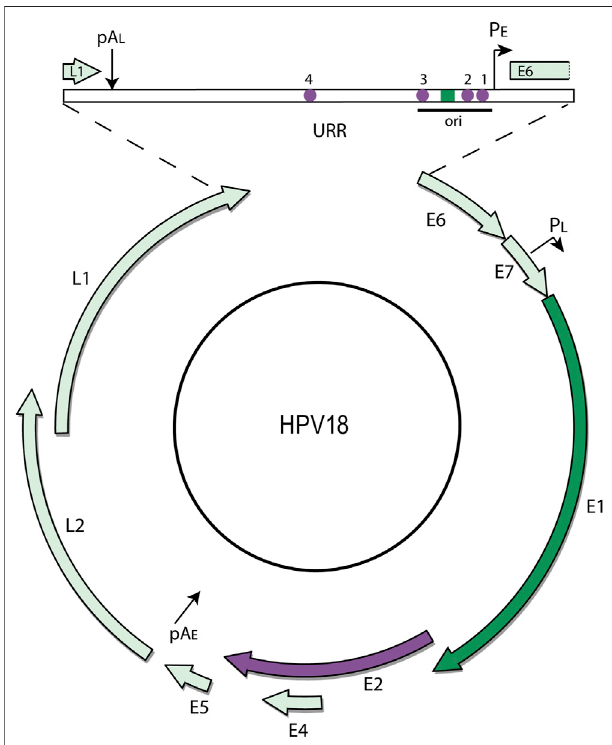
FIGURE2| HPV18genomemap.The(8kbp)circulardsDNAgenomeof HPV18 is shown. Only one strand of the DNA is transcribed, and transcription is initiated from the early and late promoters (P E and P L ) and terminated at the earlyandlatepolyadenylationsites(pA E andpA L )asindicated.Themajor open reading frames are represented by arrows. The URR (upstream regulatory region) contains the replication origin and E1 and E2 binding sites. The E1 ORF and corresponding binding site is highlighted in dark green, and the E2 ORF and corresponding binding sites in